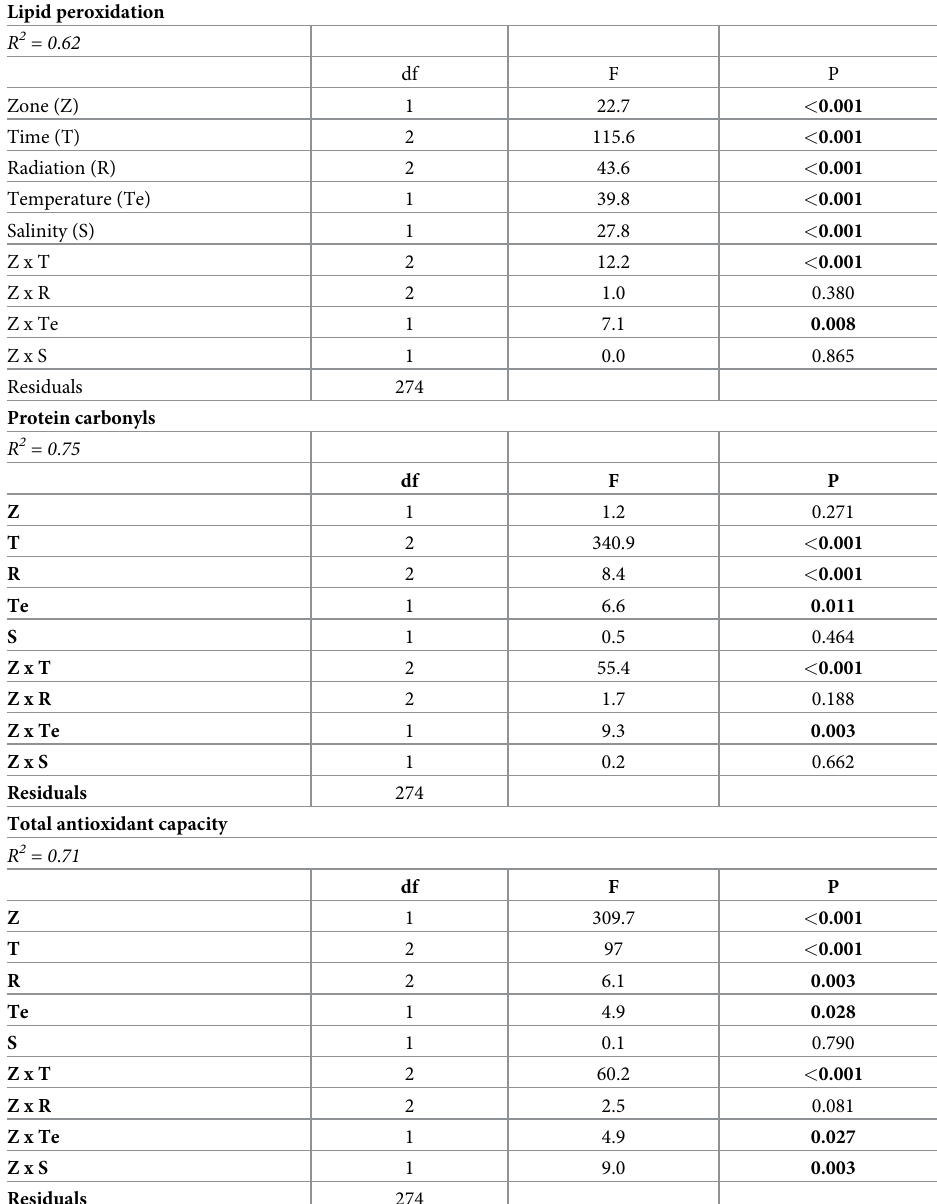
274 Summary of statistical analyses of the effects of bathymetric zone (intertidal or subtidal), time (0, 24, or 48 h), radiation (P, PA, or PAB), temperature (10 or 30˚C), and salinity (10 or 30 ppt) treatments on peroxidation, protein carbonyl levels and total antioxidant capacity of the estuarine anemone A . hermaphroditica . For each response variable, the global model took the form of y = Z � ( T + R + Te + S ). Goodness-of-fit (R 2 ), degrees of freedom (df), and P- values are provided. P-values < 0.05 are in